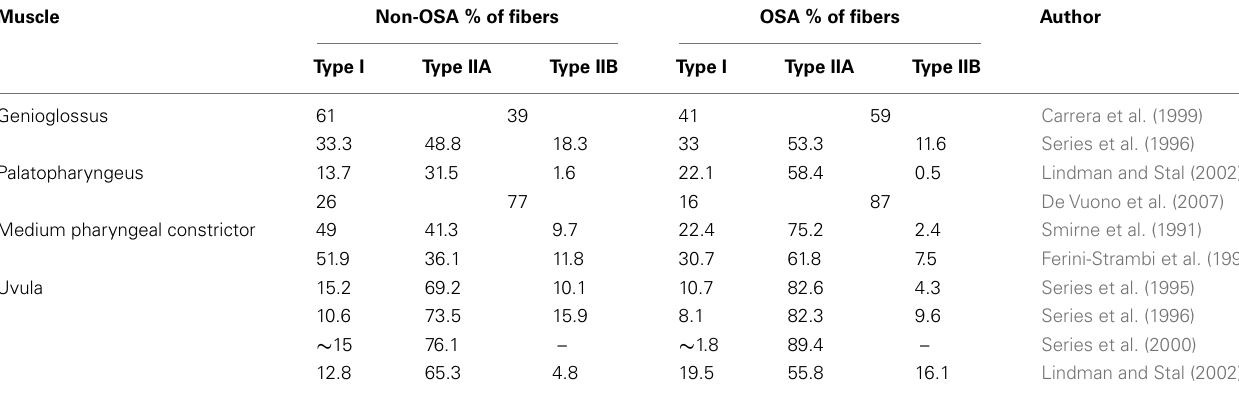
Table 1 | Percentage ofType I,Type IIA, andType IIB muscle fibers in non-OSA and patients with OSA.